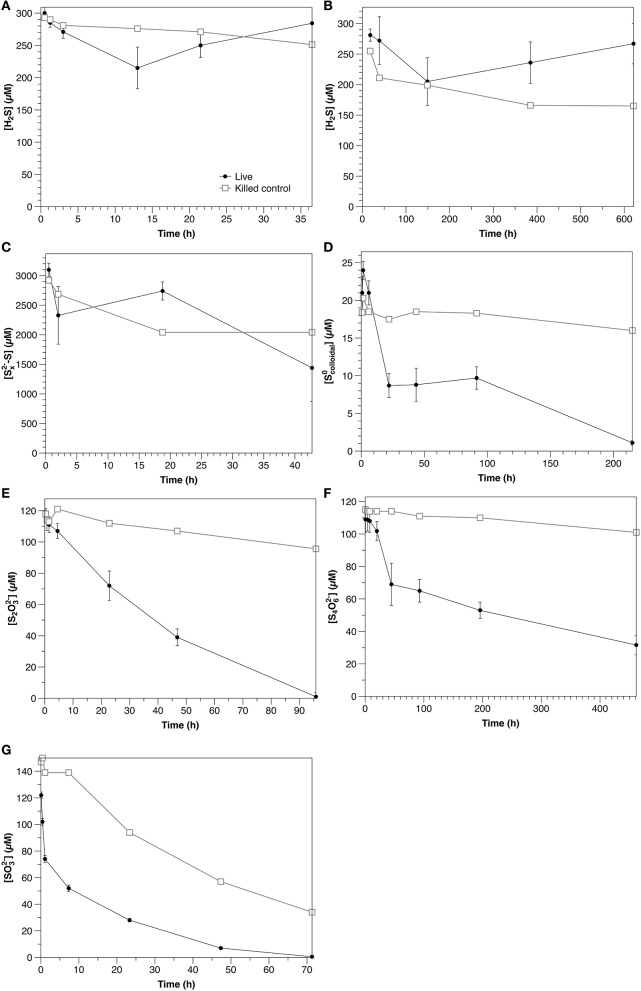
Time course of water column amendment experiments in live and killed control experiments. (A) Exp. 1; (B) Exp. 2; (C) Exp. 3; (D) Exp. 4; (E) Exp. 5; (F) Exp. 6; (G) Exp. 7. Error bars represent three independent replicates. Please note that the scales of both the concentration (y) and time (x) axes change for each experiment.